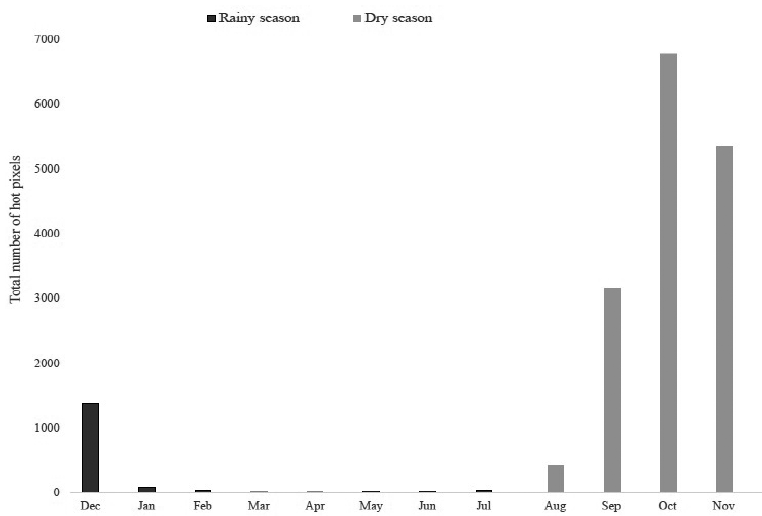
Figure 5. Total fires per month in the Cerrado of Amapá, 2007 – 2016. Total number of hot pixels in the Cerrado of Amapá between 2007 and 2016 in the rainy and dry seasons (summed across all municipalities and all years). The hot pixels were quantified as described in the legend of Figure 4. The classification of months in to the rainy and dry seasons followed Tavares (2014).